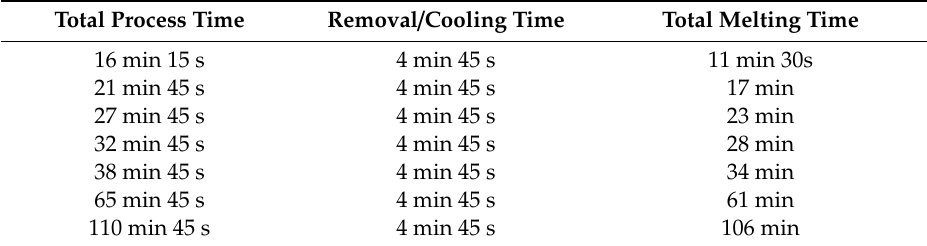
Table 1. Sample melting and cooling profiles used to generate the fused beads.